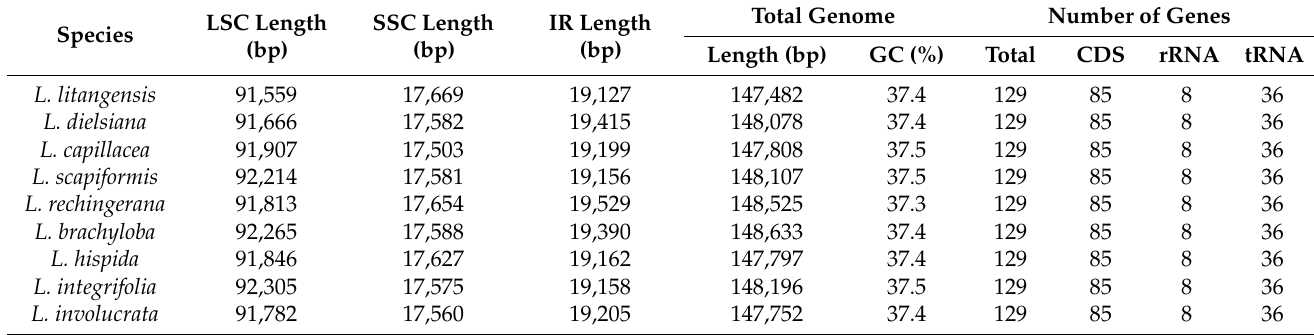
Figure 3. Under the unified parameter setting and annotation standard, 129 genes were annotated in the whole plastome of L. litangensis , which included 85 protein-coding genes (PCGs), 36 transfer RNA genes (tRNAs), 8 ribosomal RNA genes (Ribosomal RNA genes), rRNAs) and 2 pseudogenes. Table 1. Comparison of genome content of 12 Ligusticopsis species plastomes. Pseudogenes not